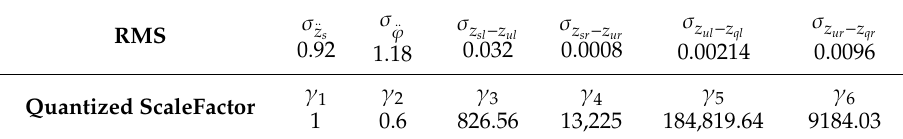
Table 2. Quantized scale factor values